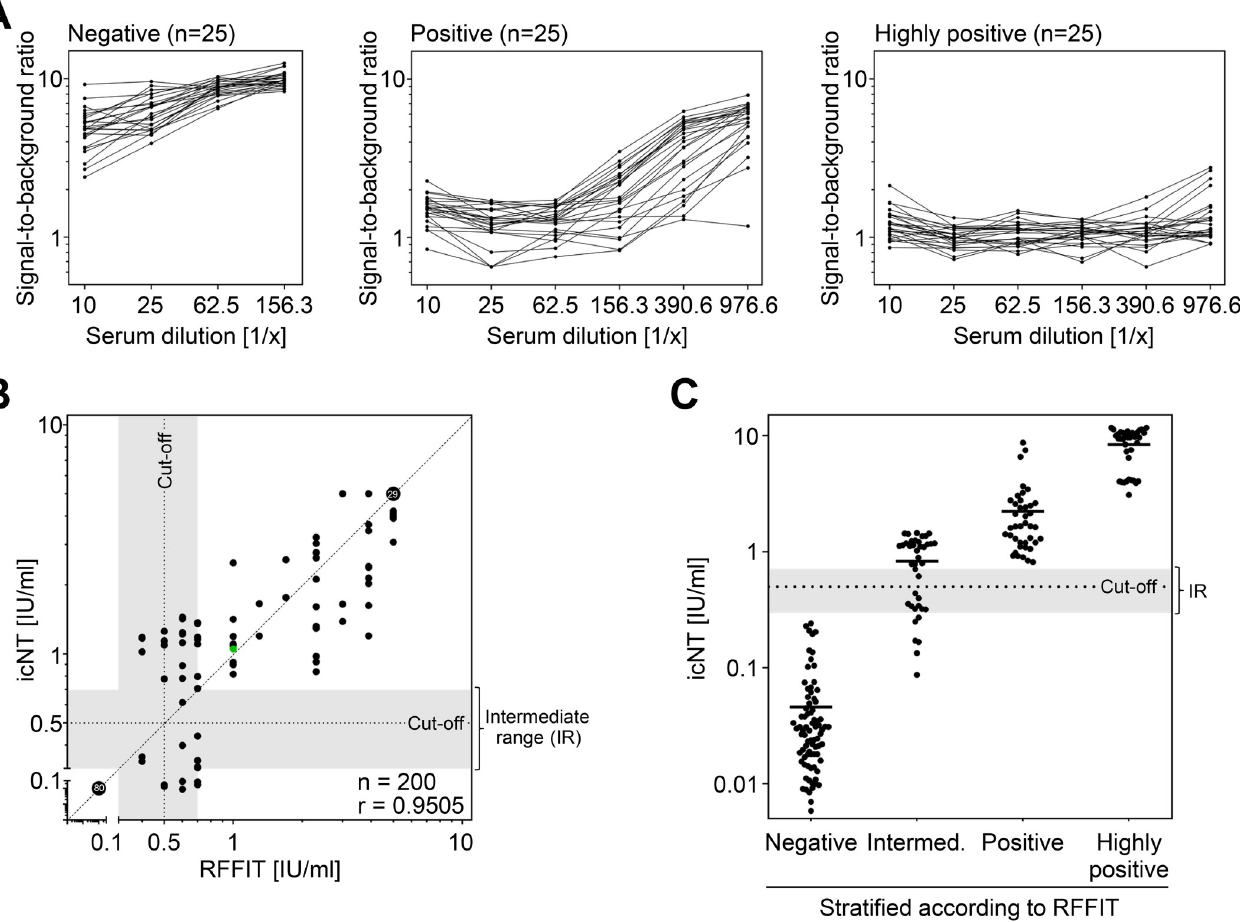
Fig 4. The icNT shows very good sensitivity and specificity. (A) 25 seronegative, 25 positive, and 25 highly positive exemplarily chosen serum samples with known RFFIT titers were analyzed by icNT at indicated serum dilutions. (B) Concordance of icNT versus RFFIT according to nAb titer, both calculated by the Reed-Muench method for n = 200 sera. Since our diagnostic RFFIT does not further stratify negative ( < 0.3 IU/ml) and highly positive ( > 4 IU/ml) samples, negative and highly positive sera were arbitrarily set to 0.1 and 5 IU/ml, respectively, in both assays. Please note: 80 negative and 29 highly positive sera are superimposed (indicated by bigger dots). The dashed line depicts the ideal linear regression line. The dotted line depicts the cut-off titer of 0.5 IU/ml and the intermediate range (0.3–0.7 IU/ml) is shaded in grey. Linear regression was analyzed by the Pearson correlation coefficient, r = 0.9505, p (two-tailed) < 0.0001. (C) icNT results of the sera shown in (B). Serum samples were stratified based on the RFFIT results to the indicated groups.